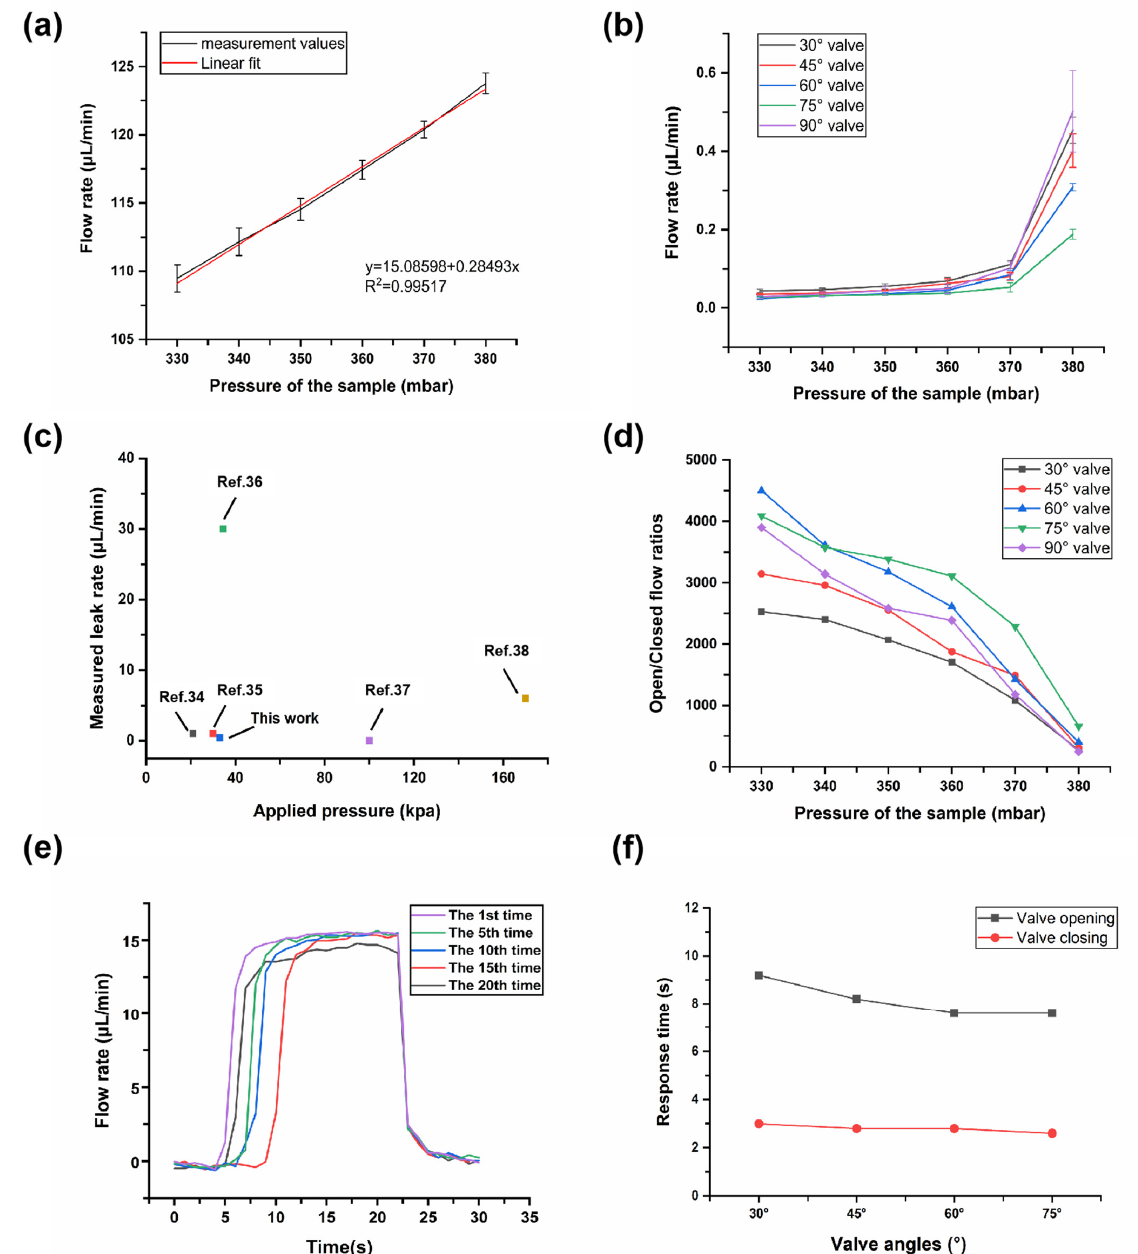
Figure 6. Leakage and response time tests of microvalves. ( a ) A line graph of sample flow rate as a function of pressure when the valve was opened. ( b ) A line graph of sample flow rate as a function of pressure when the valve was closed. ( c ) Comparison of our microvalve and other microvalves reported in the current literature on leak rate. ( d ) A line graph of the open/closed flow ratios of the valves under different pressures. ( e ) The relationship curve between the flow rate and time for one complete switching process of a 30° valve. ( f ) Response times for all valves of different angles.